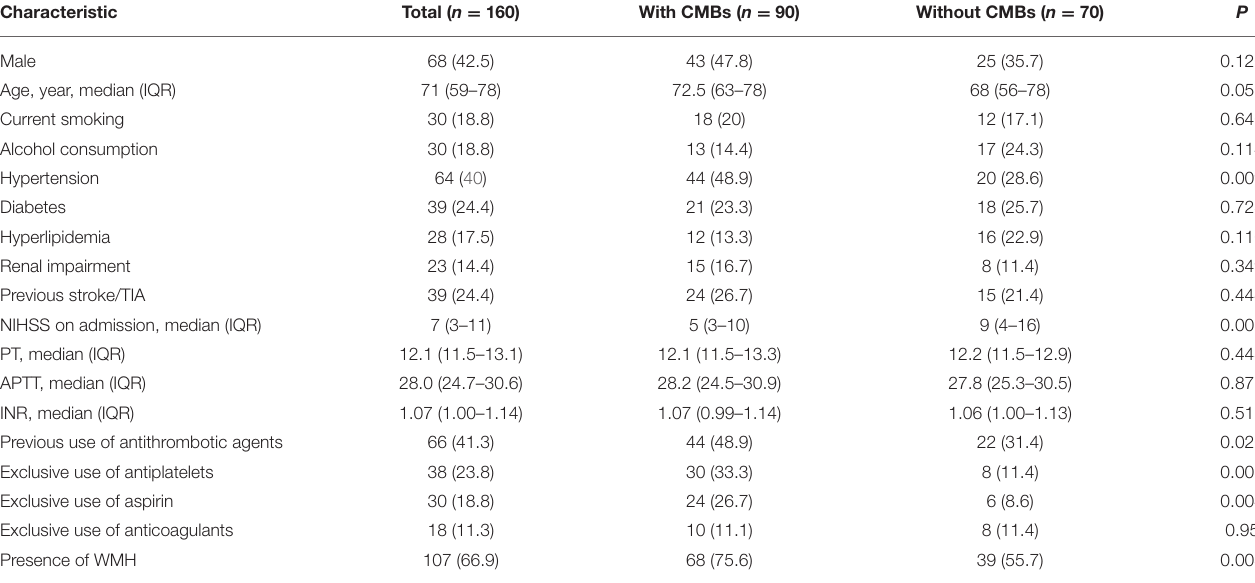
TABLE 1 | Baseline characteristics of patients with and without cerebral microbleeds.